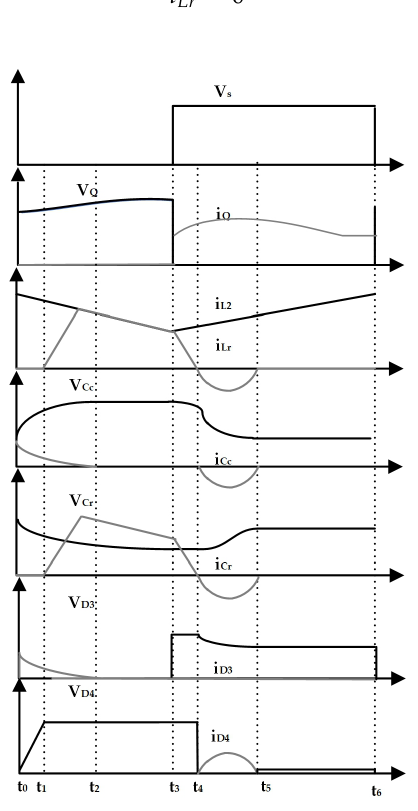
Figure 3. Key operation